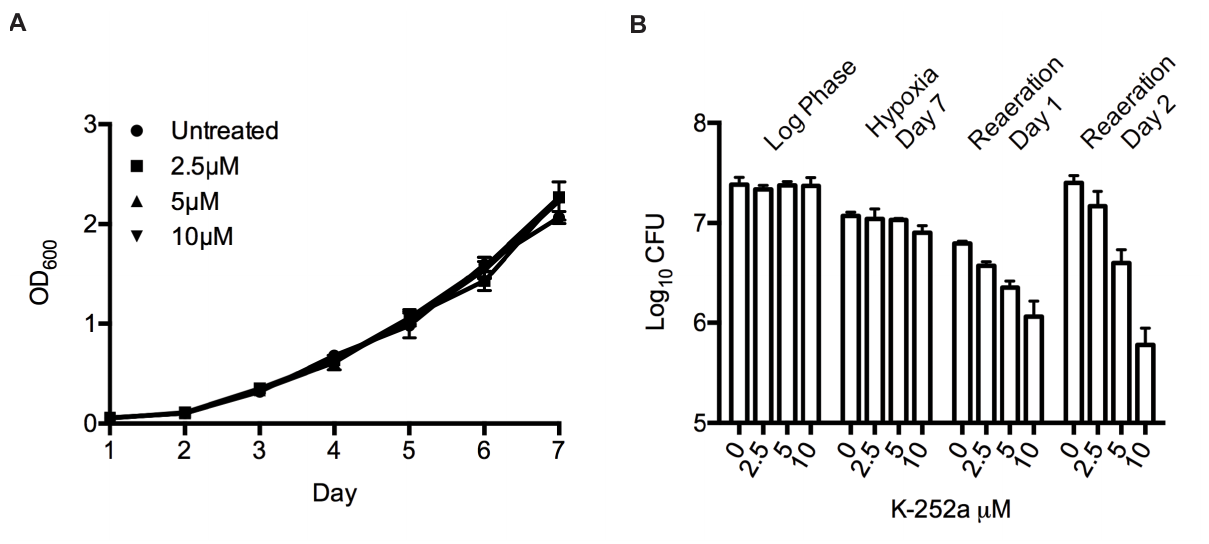
Figure 3. Chemical inhibition of PknB compromises viability in reaeration. (A) Wild-type Mtb in log phase was treated with sub-MIC concentrations of K252a, and growth in aerated culture was measured for 7 d. (B) Viability during a hypoxia time course was determined on day 0, hypoxia day 7, and reaeration day 1 and 2 by CFU analysis. Error bars represent standard deviation.